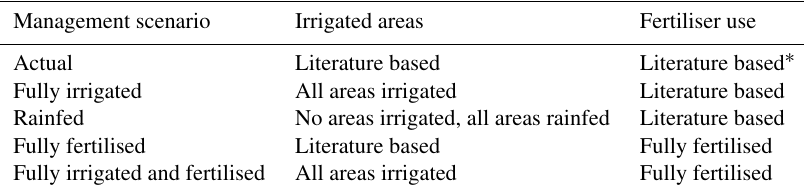
Table 2. The management scenarios used in this study. The actual set-up is used in the main analyses, while the fully irrigated, rainfed, fully fertilised, and fully irrigated and fertilised management scenarios are used for comparing the impacts in different cropping